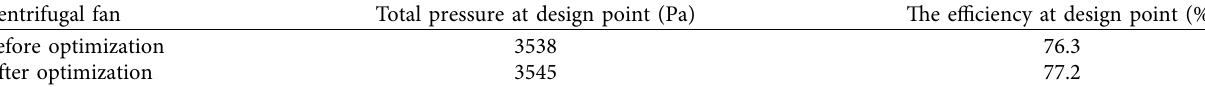
Table 4: Self-adaption Kriging surrogate model optimization algorithm.